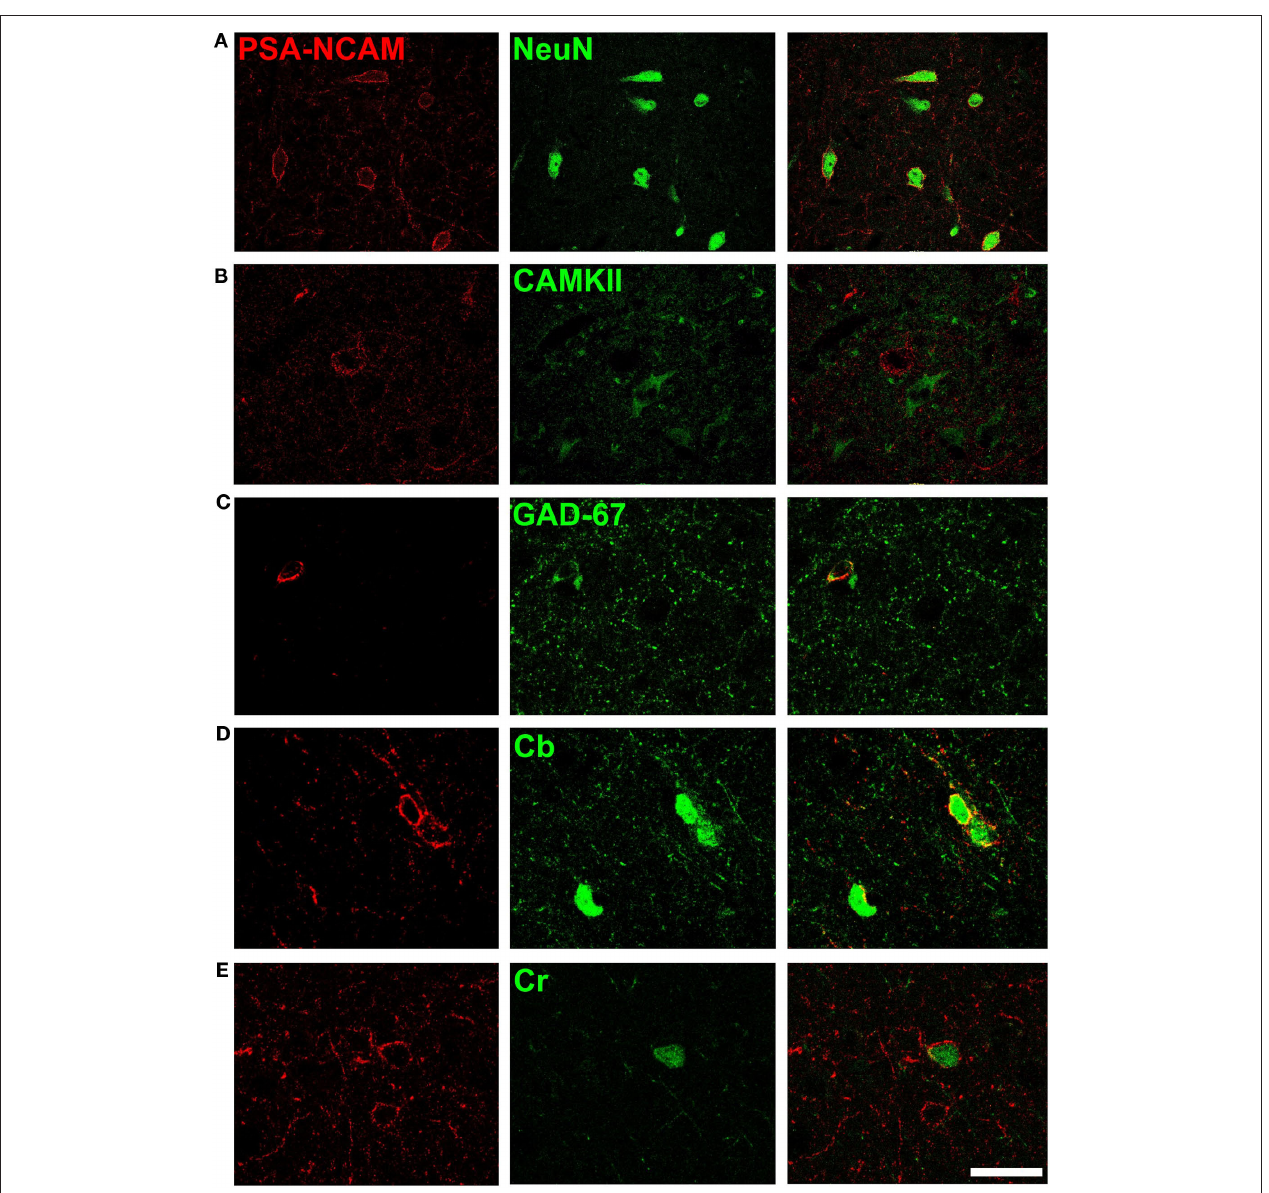
Figure 6 | Phenotype of PSA-NCAM expressing neurons in deep layers of the cat cerebral cortex. Neurons expressing PSA-NCAM in deep layers (III–VI) of the cat cerebral cortex co-express NeuN (A) but they do not co-express Ca(2 + )/ CaM-dependent protein kinase II (CAMKII) (B) . Many of these cells co-express